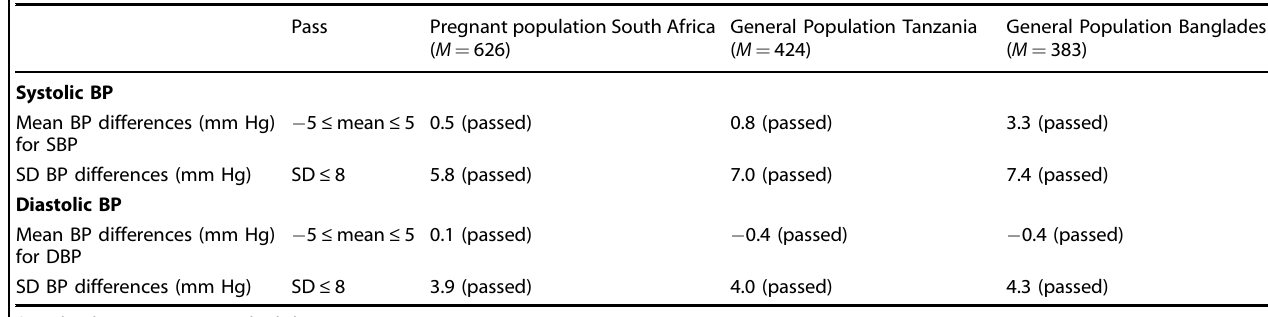
Table 3. Performance of CamBP device — ISO Criterion 1.